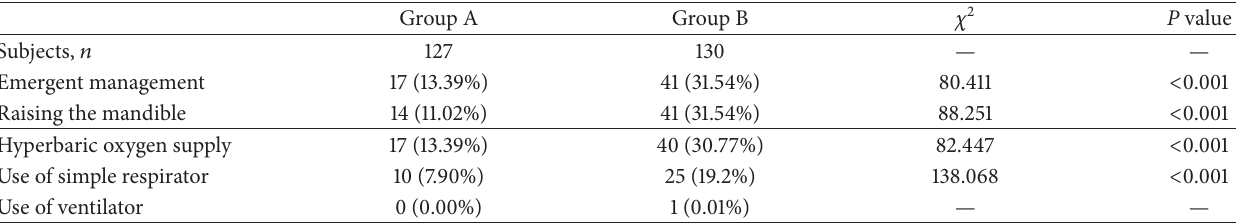
Table 2: Emergent management in the treatment groups ∗ .